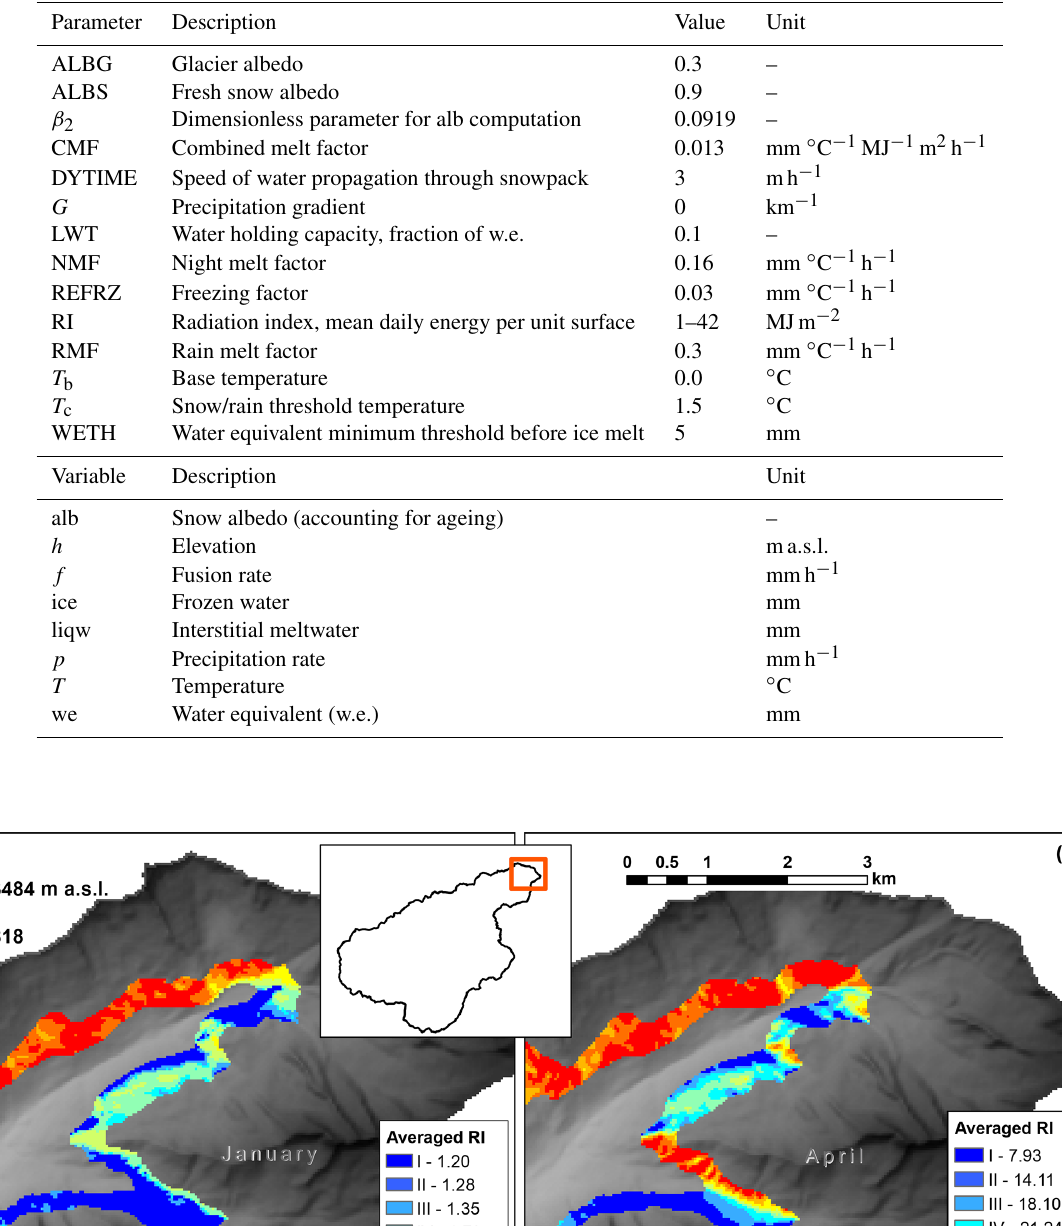
Table 1. Model parameters and variables: short name, description and measuring units. Parameters are written with capital letters, variables in lowercase.